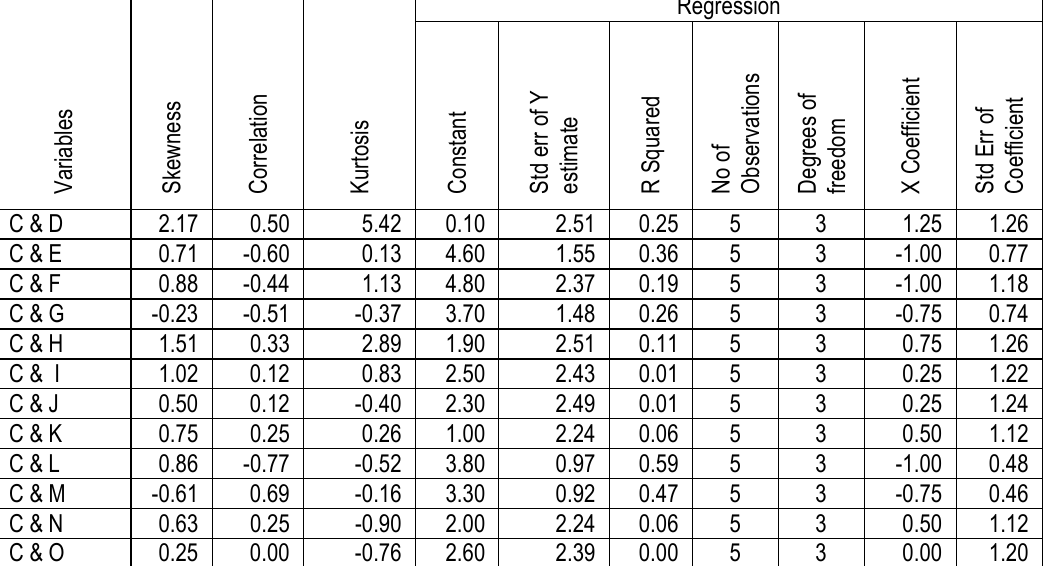
Table 4. Relationship of Supervision and Maintenance of Study Centers with other Variables